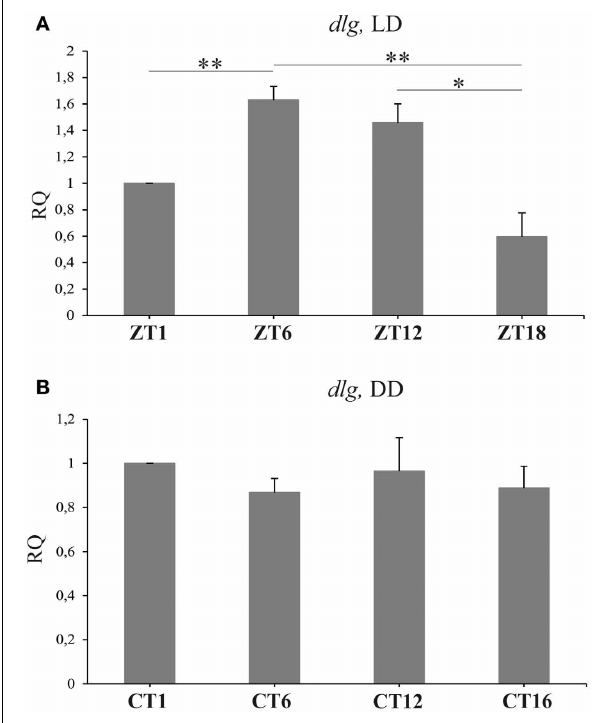
FIGURE 6 | The relative level of dlg mRNA in the brain of flies held in LD 12:12 or DD. In LD 12:12 the mRNA of dlg changes during 24h cycle with a peak in the middle of the day (ZT6) and a trough in the middle of the night (A) . No rhythm was observed in DD (B) ; ∗ p ≤ 0 . 05, ∗∗ p ≤ 0 . 01.